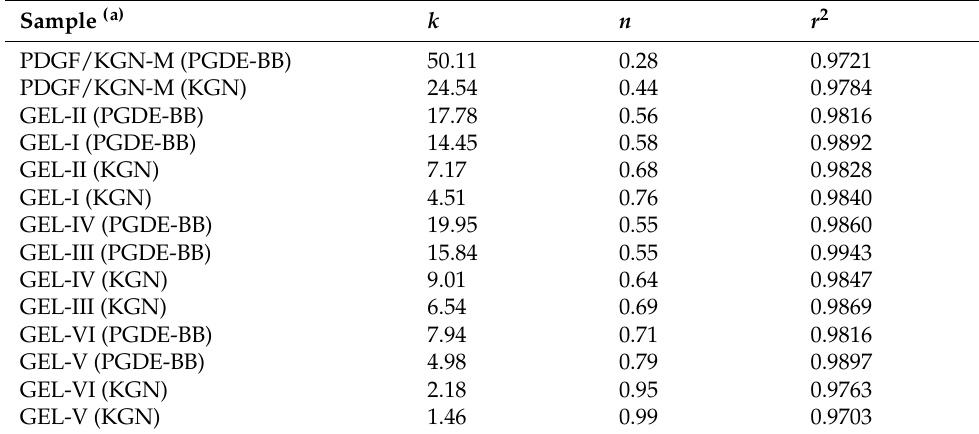
Table 3. Parameters for hydrogels containing PDGF/KGN-M microspheres (a) .